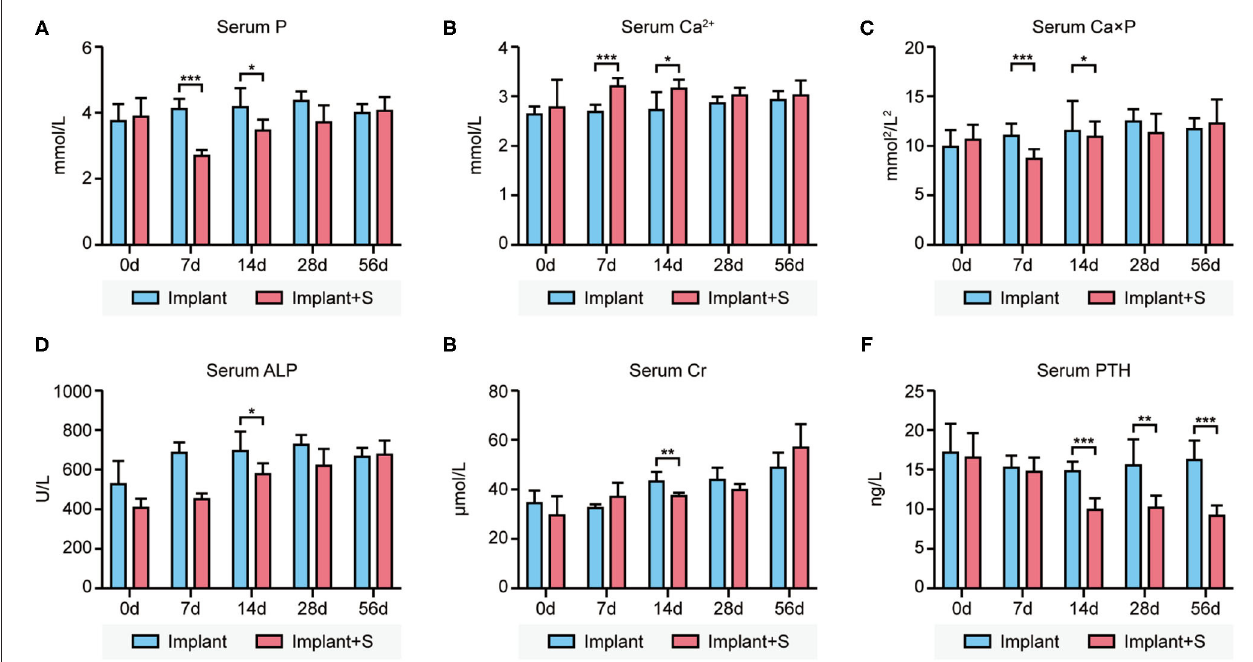
FIGURE 1 | Difference of serum biochemistry parameters between the implant and implant + S groups at days 0, 7, 14, 28, and 56 after implantation. (A) Compared to implant and implant + S group concerning serum phosphate levels, serum phosphate level decreased transiently in implant + S groups in 7–14 days. (B) Comparison between the implant and implant + S group concerning serum calcium levels. Serum calcium level increases transiently in the implant + S group in 7–14 days. (C) Comparison between the implant and implant + S group concerning serum calcium-phosphate product; serum calcium-phosphate product level decreased transiently in the implant + S group at 7 days. (D) Comparison between the implant and implant + S group concerning serum ALP. (E) Comparison between the implant and implant + S group concerning serum creatine. (F) Comparison between the implant and implant + S group concerning serum PTH level; serum PTH was decreased continuously in the implant + S group after 14 days. N = 4–6, data are mean ± SD, * p < 0.05, ** p < 0.01, *** p < 0.001.